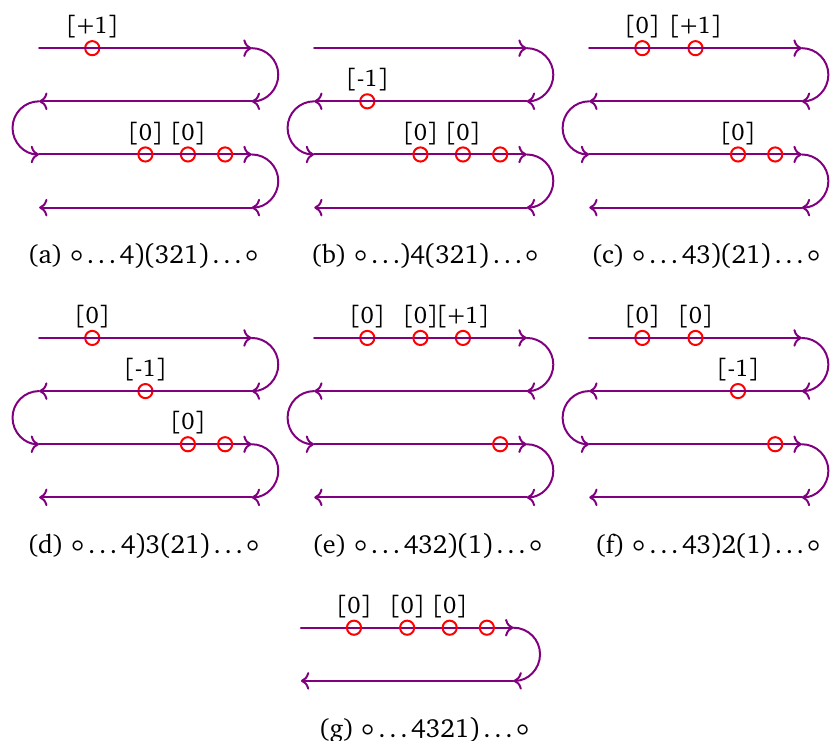
Figure 6: Same as Fig. 5, but with a different time ordering. Note that wing position assignments are the same as Fig. 5 even though the time-orderings are different. The number of wing-spread ( w = 1 ) configurations is still six, and is independent of the details of